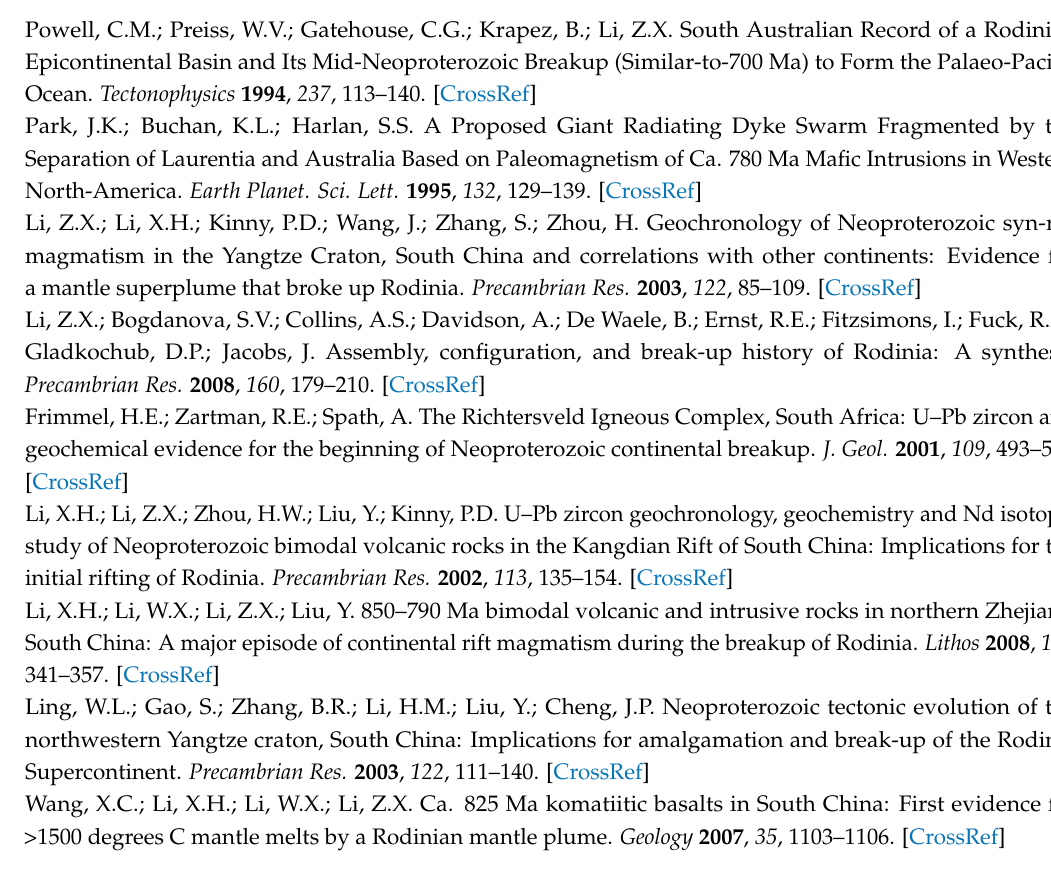
Figure S1: Diagrams of Y, Nb, Th, La, V, Hf, Rb, Sr, and Ba vs. Zr to evaluate the mobility of these elements during alteration, Table S1: Summary of published Neoproterozoic zircon U–Pb ages and corresponding Lu–Hf isotopes for basic rocks in YZB, Table S2: LA-ICPMS U–Pb isotopic compositions for zircons from the LTQ, Table S3: Trace elements (ppm) in zircons from the LTQ, Table S4: Major and trace elements data of the LTQ, Table S5: Lu–Hf isotopic data for zircons from the